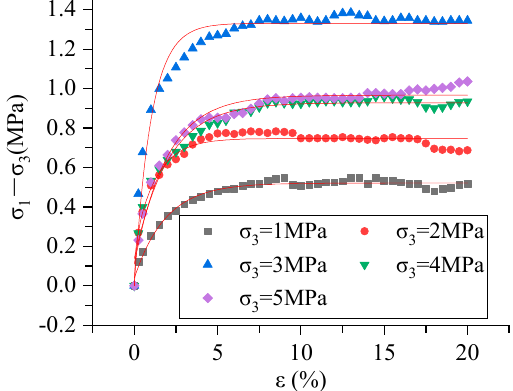
Figure 9. Triaxial stress–strain curves of sediments containing spherical hydrates ( 𝑟 = 8.5 𝑚𝑚 ).